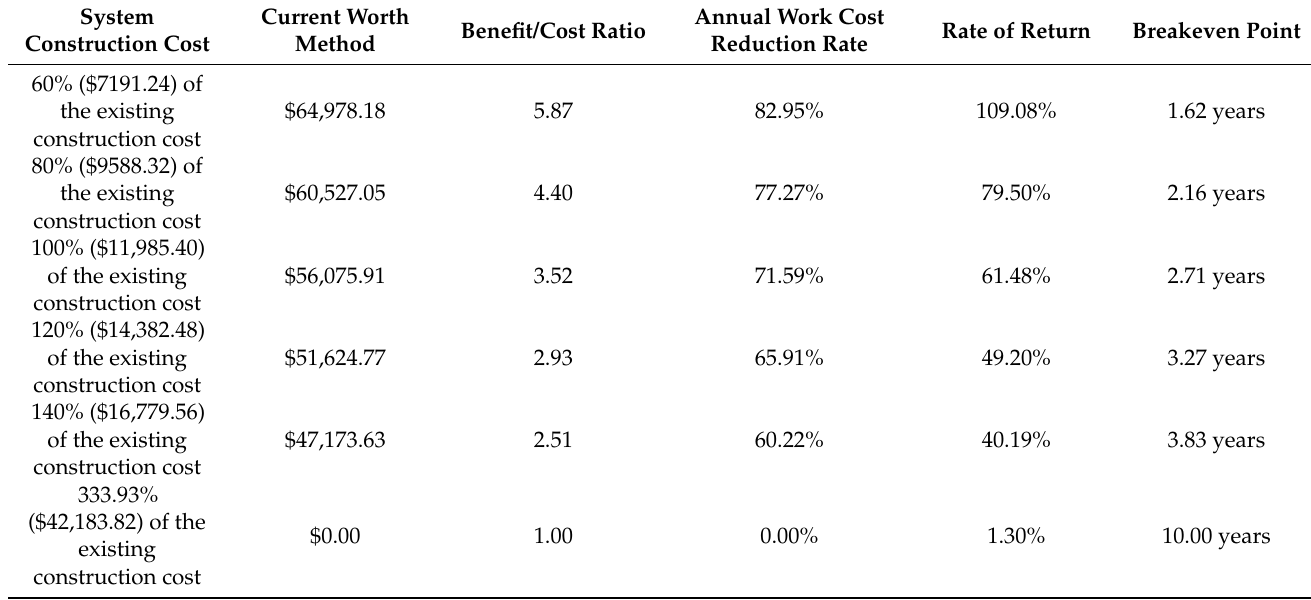
Table A3. Sensitivity analysis results according to the system construction cost.